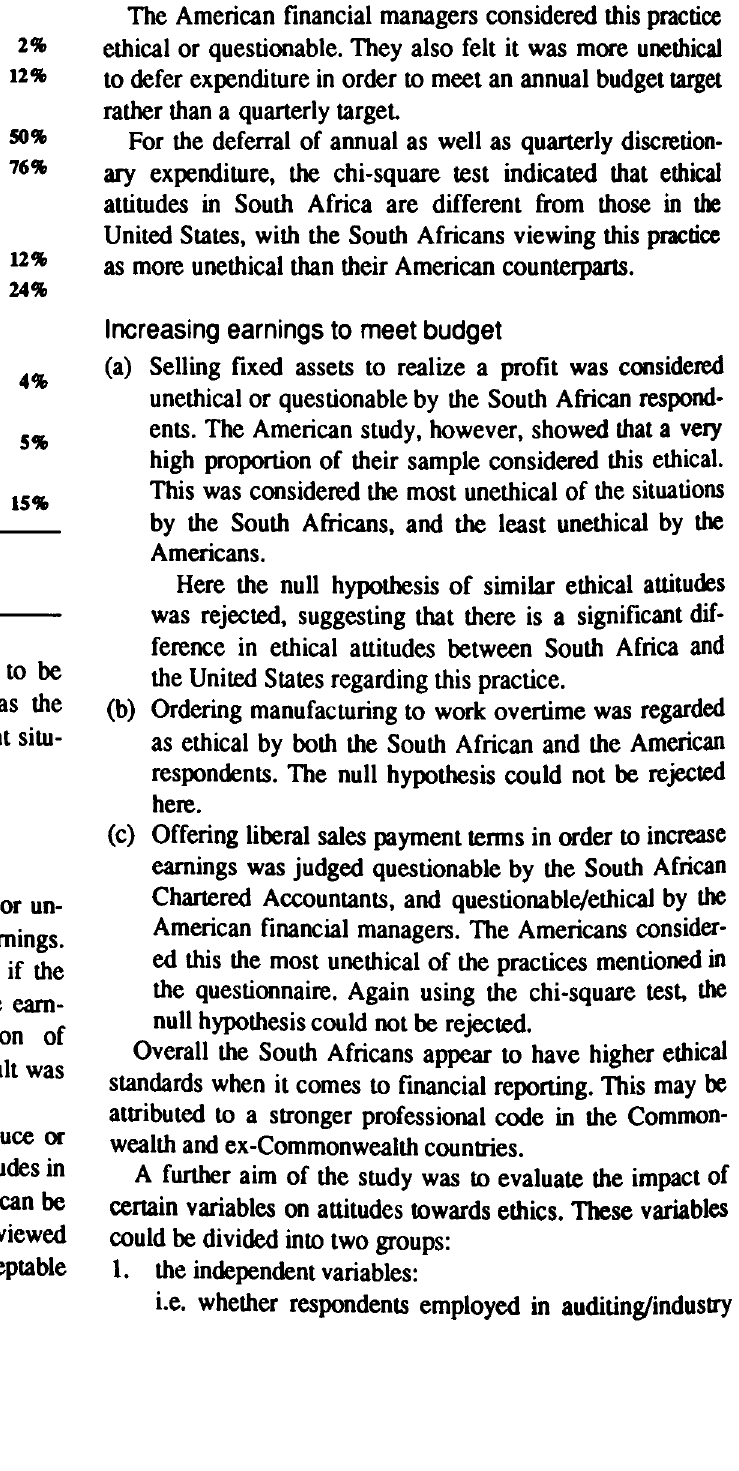
Table 4 South African versus United States results